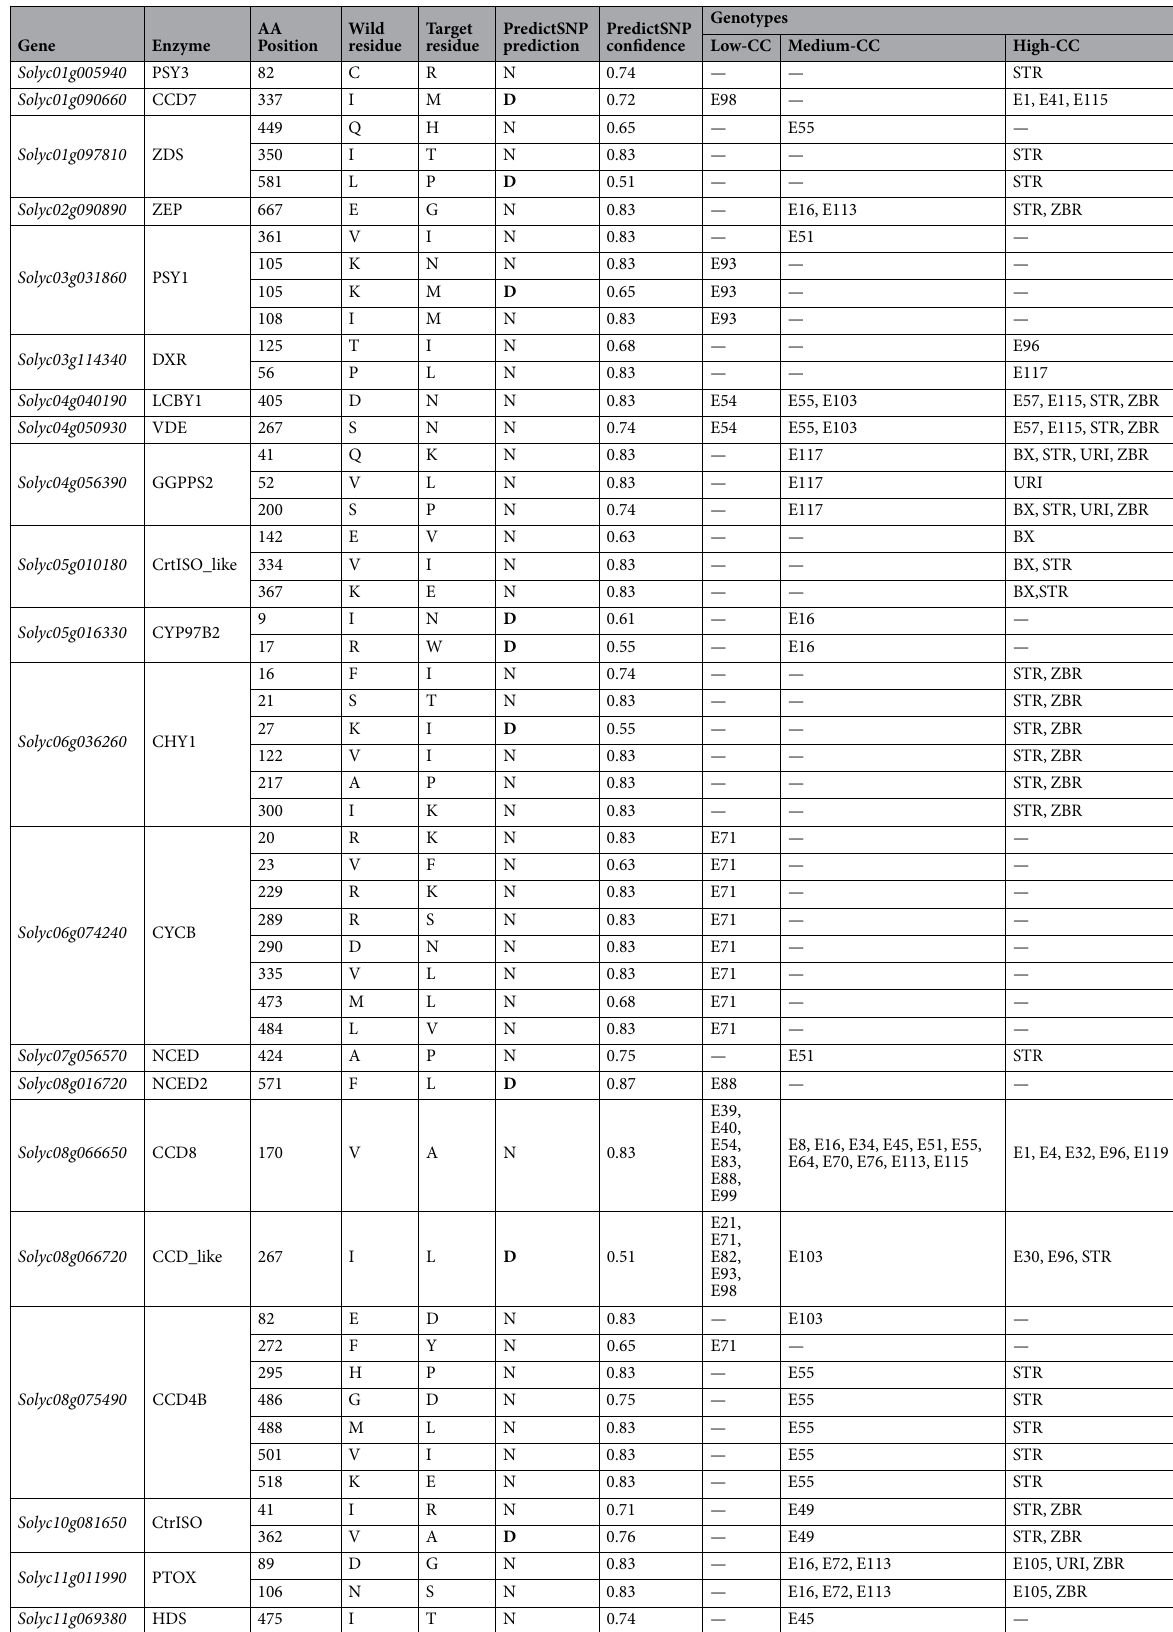
Table 2. List of missense mutations coupled with prediction on the effect of amino acid substitutions by PredictSNP. N = Neutral; D =